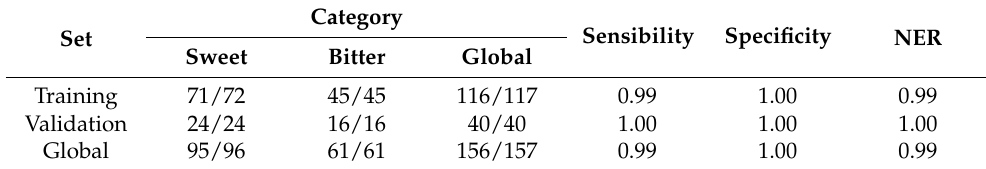
Table 1. Discriminant models for classifying sweet almond batches by bitterness using the mean spectrum.